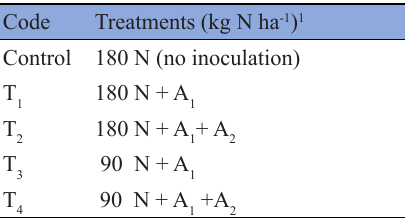
Table 2. Nitrogen levels and inoculation treatments in the